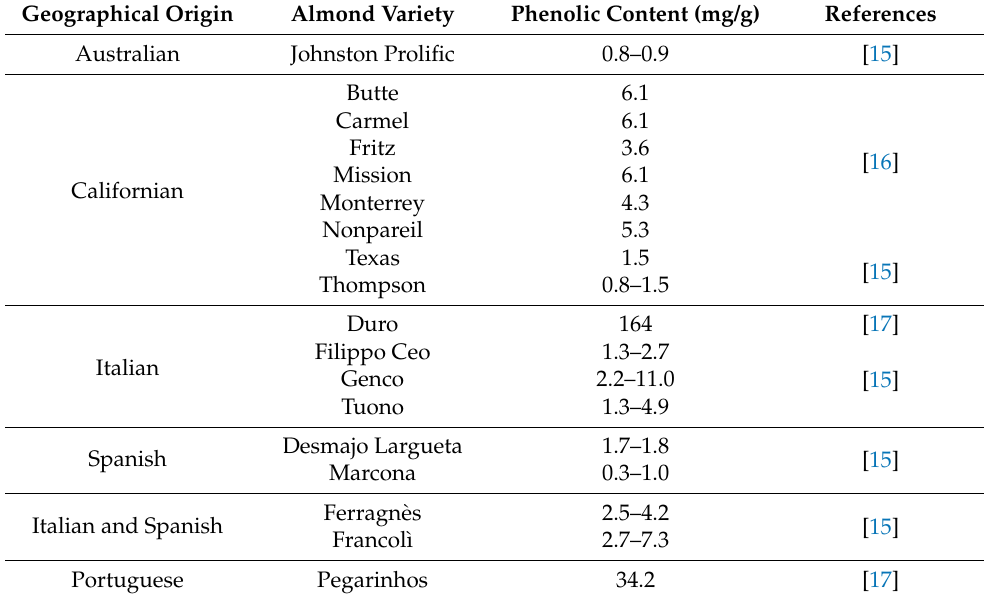
Figure 2. Major bioactive compounds isolated from almond and almond by-products. Table 1. Total content of polyphenols of different almond varieties from diverse geographical origins (expressed as mg of gallic acid/g